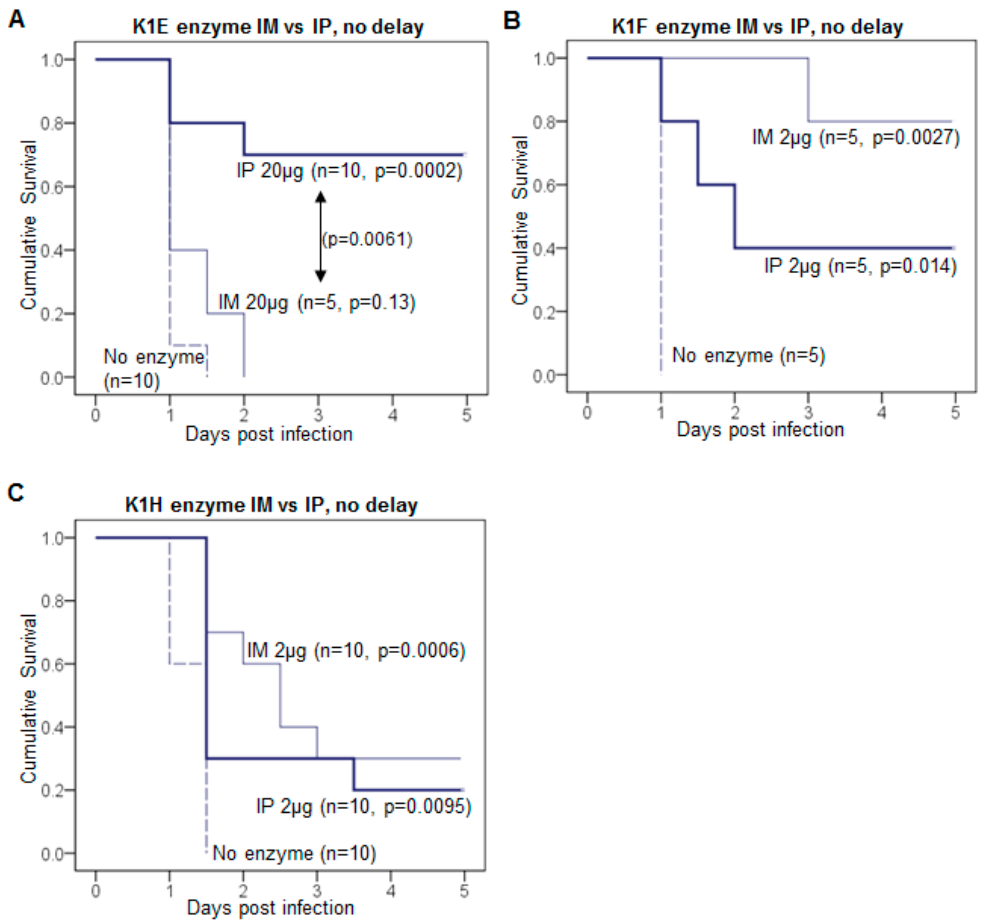
Figure 4. Administration route can affect treatment efficacy. ( A – C ) Kaplan-Meier survival curves of depolymerase treatment comparing intramuscular (IM) to intraperitoneal (IP) inoculation in mice. ( A ) Treatment with 20 µ g K1E; ( B ) Treatment with 2 µ g K1F; ( C ) Treatment with 2 µ g K1H. In all mice, 1.2–2.9 × 10 8 CFU of K1-capsulated E. coli were injected IM, followed by inoculation of enzyme either IM in the contralateral thigh or IP. Mouse survival was monitored for 5 days and the cumulative probability of survival was plotted for each treatment. The mouse number n of each treatment is labeled by each curve. Log rank test: p values between enzyme treatment and the no-enzyme control, or significant p values between IM and IP treatment are